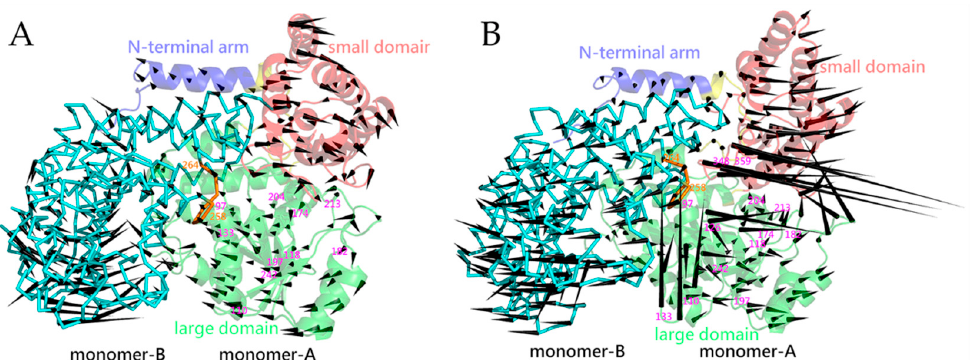
Figure 5. Porcupine plots showing the largest-amplitude collective motion along the first eigenvector. ( A , B ) The most significant motion modes of mSHMT and pSHMT, respectively. In a dimer, the monomer-A is rendered in cartoon repre- sentation, with the N-terminal arm, large domain, and small domain colored blue, green, and red, respectively; the mon- omer-B is rendered in ribbon and colored cyan. In the monomer-B, a small segment (residues 258–264) that participates in the formation of the inner “wall” of monomer-A’s active-site cavity is colored orange. In the monomer-A, the residue numbers for the starting and ending residues of the segments participating in the formation of the active-site cavity are